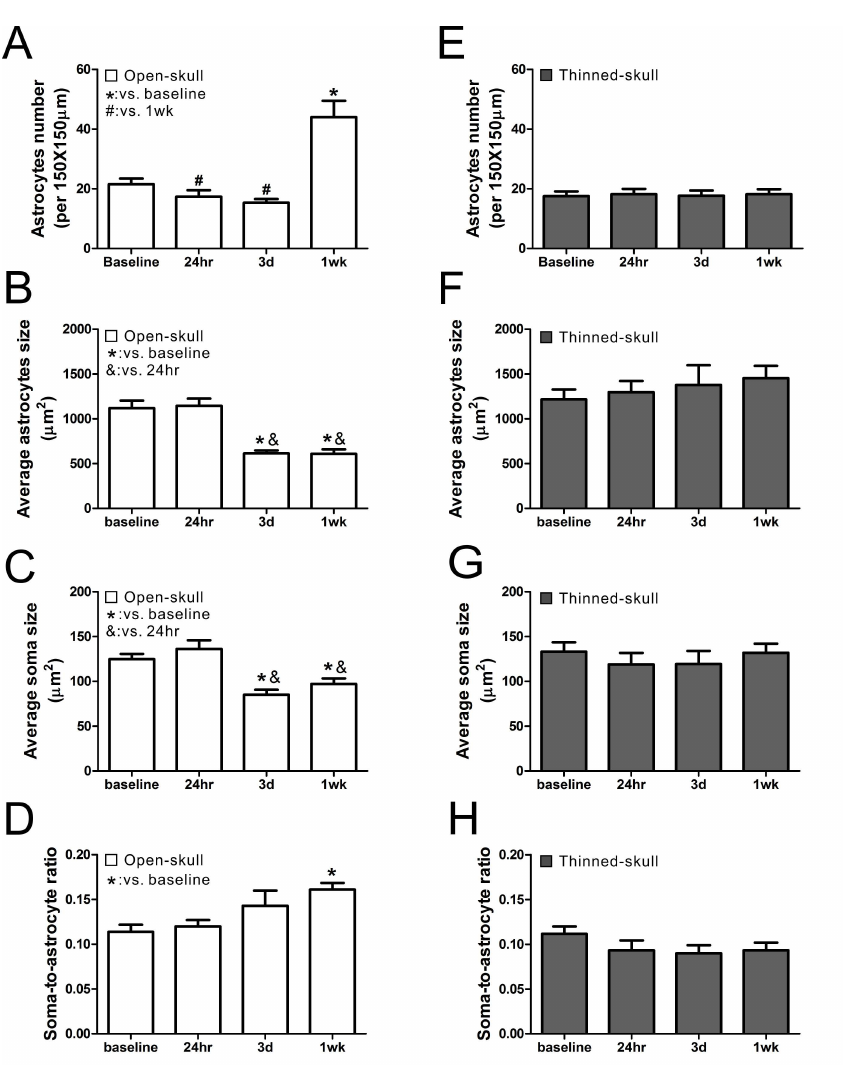
Fig 3. Comparisonof astrocyte number and morphologicalfeatures betweenopen-skull technique(A-D) and thinned-skull technique(E-H). (A) In the open-skulltechnique, the numberof astrocytes decreased at 24 hr and 3 d then increasedat 1wk after surgery. (B-D) The size of astrocytes and their somas decreased at 3 d and 1 wk after surgery (B, C), whilethe ratio of the soma to astrocyte size increasedat 1wk after surgery (D). (E-H) In the thinned-skull technique, no significantchangewas observed in astrocyte number, astrocyte or soma size, and the soma-to-astrocyte ratio at all observedtime points after surgery. * ,#,& p < 0.05by one way ANOVA with Tukey’s post-test (n = 6 per